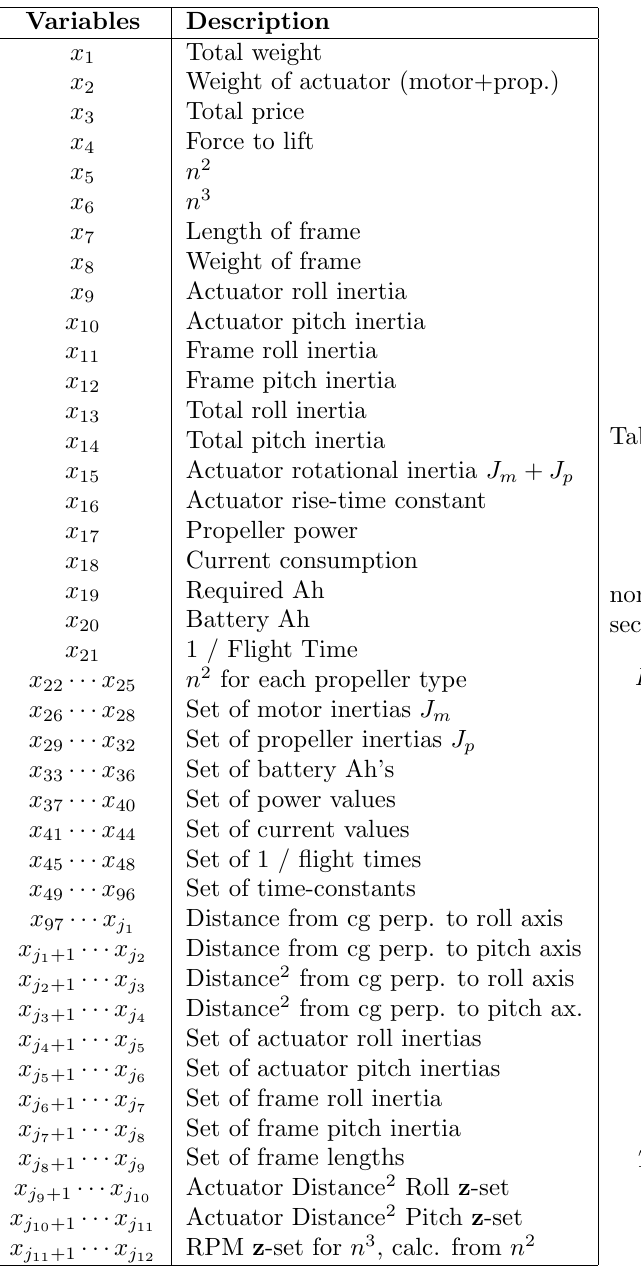
Table 3: Continuous variables used in the design opti- mization. ”cg perp. to” = ”center of gravity perpendicular to”.